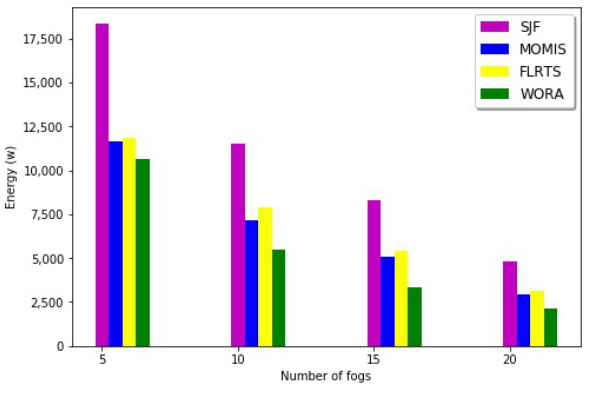
Figure 8. Computation of energy consumption for fog with 500